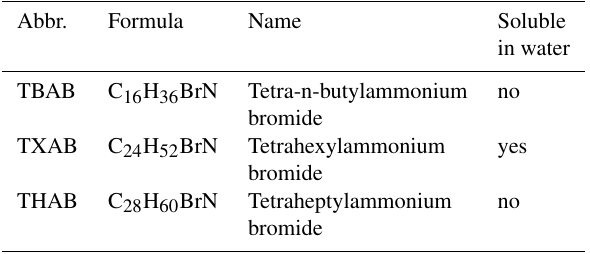
Table 1. Molecular standards dissolved in ethanol Abbr.